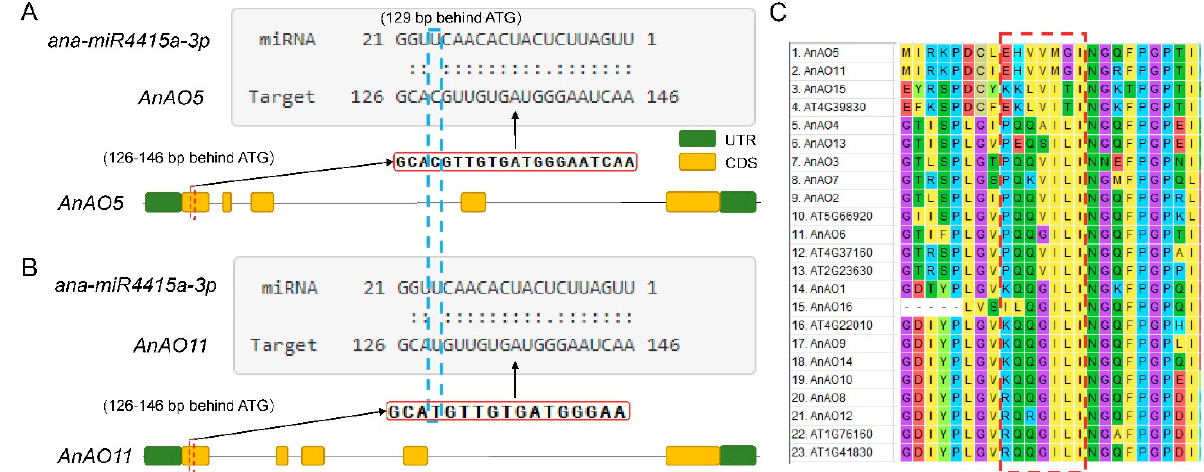
Figure 5. Binding sites of ana-miR4415a-3p on AnAO genes, as predicted by psRNAtarget. ( A ) AnAO5 was targeted by ana-miR4415a-3p. ( B ) AnAO11 was targeted by ana-miR4415a-3p. ( C ) Multi-sequence alignment of AnAOs protein and AtAOs protein depicting the difference in the amino acid sequence of AnAOs corresponding to the binding sites of ana-miR4415a-3p. Red dotted line box represents the amino acid sequence encoding the nucleotides at the binding site of ana- miR4415a-3p.